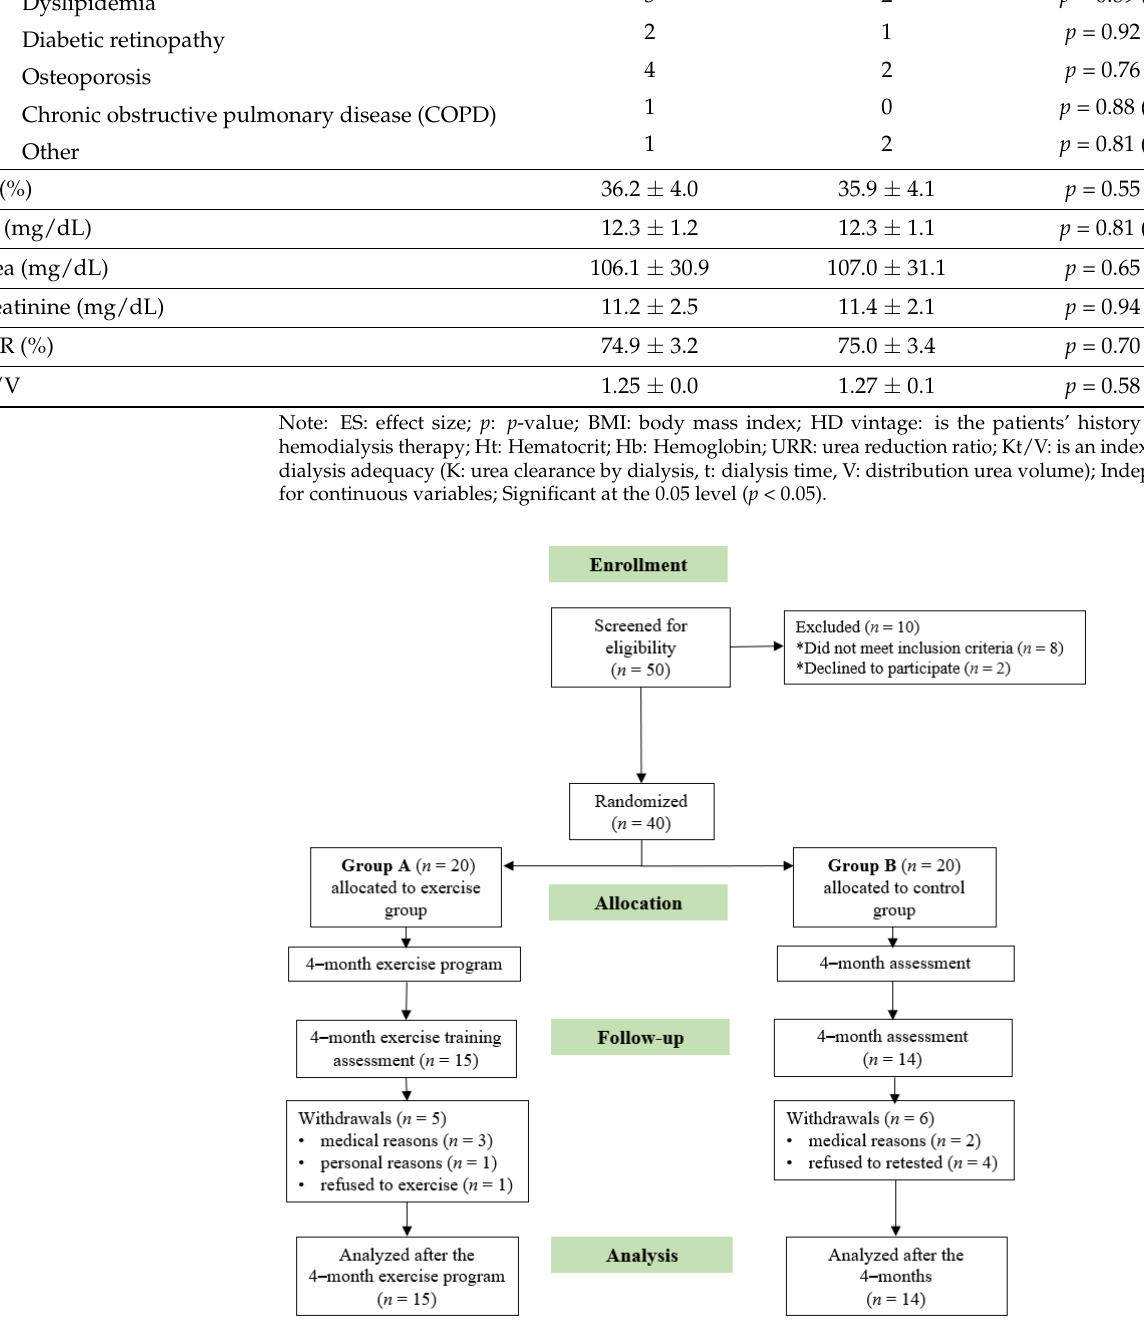
Figure 2. Flow chart diagram of the study. Table 1. Clinical characteristics of the KT candidates.